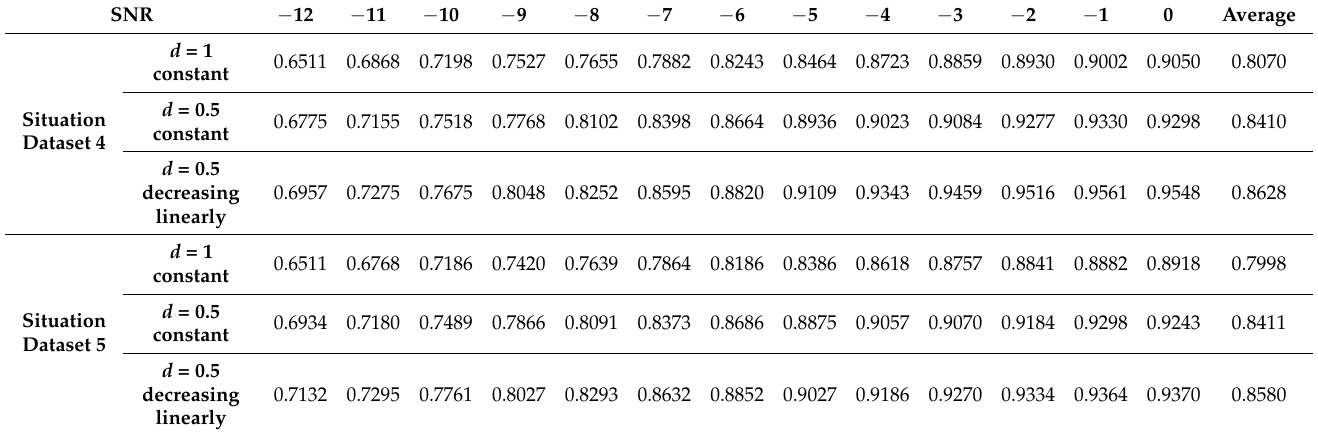
Table 10. Semi-supervised classification result with the datasets with different strategies of self-paced data